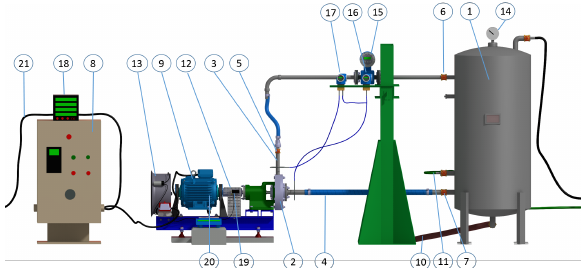
Figure 3: Scheme of the test rig (3D model) used in course of the ex-